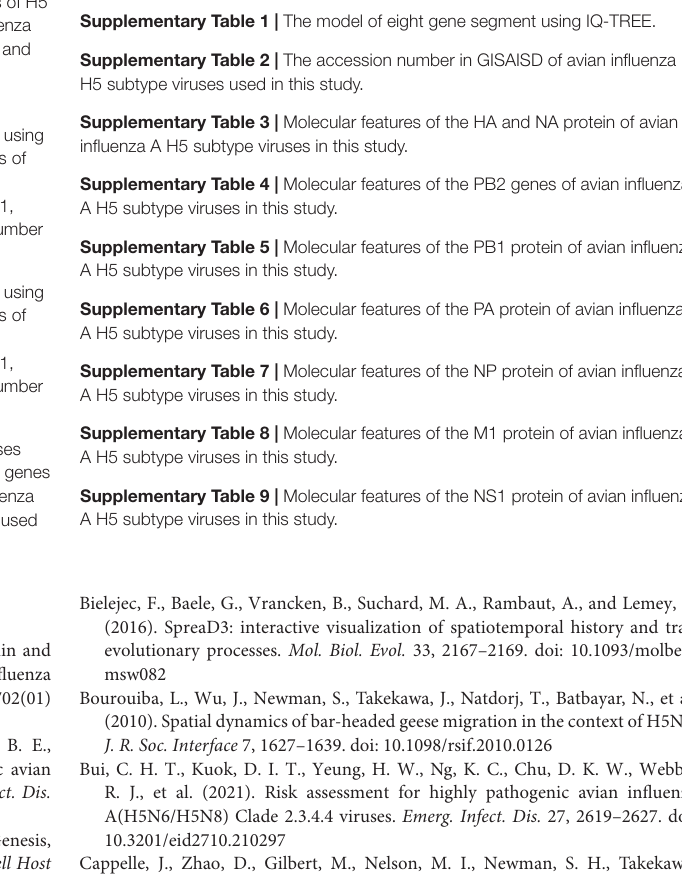
in this study. The scale bar represents the number of nucleotide substitutions per site (subs/site). Supplementary Figure 7 | Phylogenic tree of H5N6 subtype influenza viruses using NA gene sequences with available the other influenza viruses. The NA genes of H5N6 viruses collected during 2021 in China together with the other influenza viruses were analyzed. The isolates with red color denote the H5N1, H5N6, and H5N8 viruses used in this study. The scale bar represents the number of nucleotide substitutions per site (subs/site). Supplementary Figure 8 | Phylogenic tree of H5N8 subtype influenza viruses using NA gene sequences with available the other influenza viruses. The NA genes of H5N8 viruses collected during 2021 in China together with the other influenza viruses were analyzed. The isolates with red color denote the H5N1, H5N6, and H5N8 viruses used in this study. The scale bar represents the number of nucleotide substitutions per site (subs/site). Supplementary Figure 9 | Phylogenic tree of H5 subtype influenza viruses using M gene sequences with available the other influenza viruses. The M genes of H5 subtype viruses collected during 2021 in China together with the other influenza viruses were analyzed. The isolates with red color denote the H5N1, H5N6, and H5N8 viruses used in this study. The scale bar represents the number of nucleotide substitutions per site (subs/site). Supplementary Figure 10 | Phylogenic tree of H5 subtype influenza viruses using NS gene sequences with available the other influenza viruses. The NS genes of H5 subtype viruses collected during 2021 in China together with the other influenza viruses were analyzed. The isolates with red color denote the H5N1,